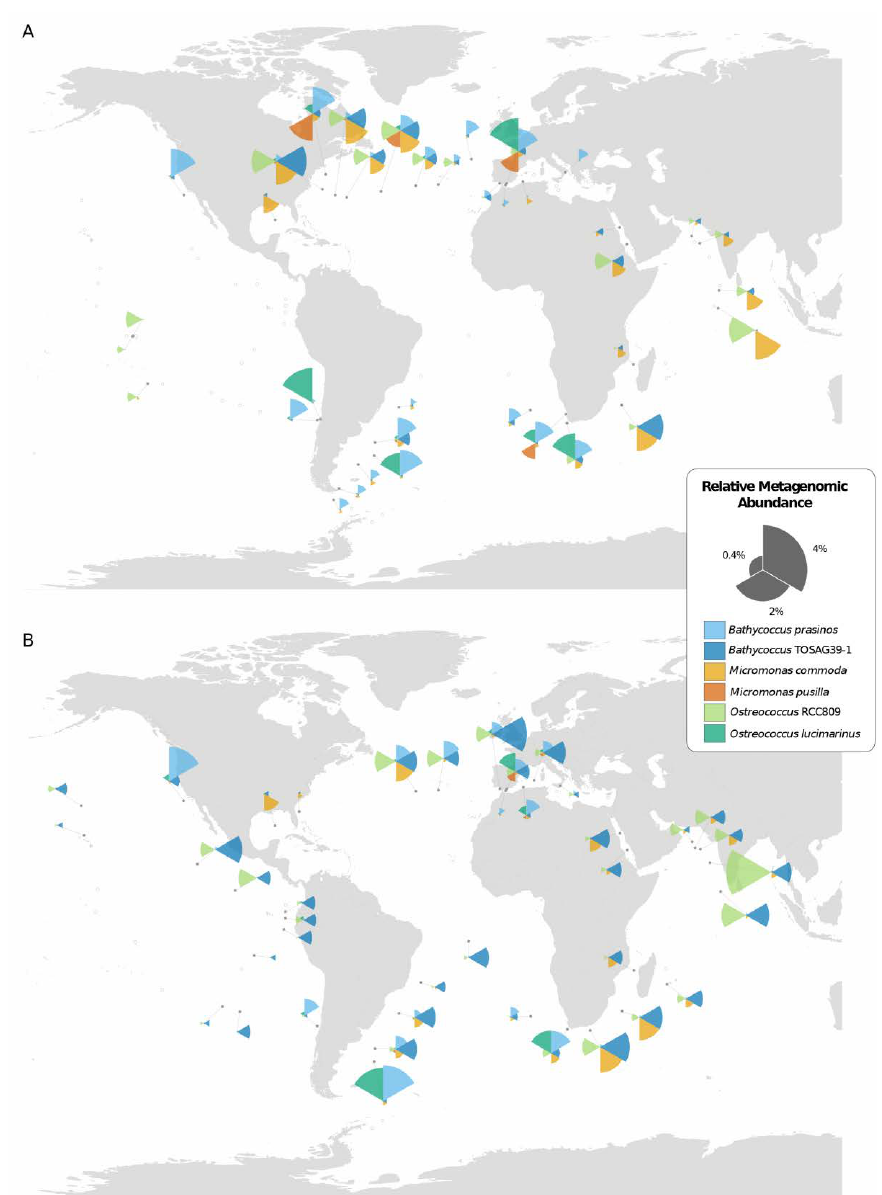
Figure 1. Geographical distribution of the six Mamiellales genomes in Tara Oceans stations from ( A ) surface and ( B ) deep-chlorophyll maximum (DCM) waters, as inferred from the relative abundance of recruited metagenomic reads. Samples with less than 0.1% relative abundance of a species are displayed as an empty circle. The sizes of the segments of coxcomb charts indicate the relative genomic abundances of the corresponding Mamiellales.